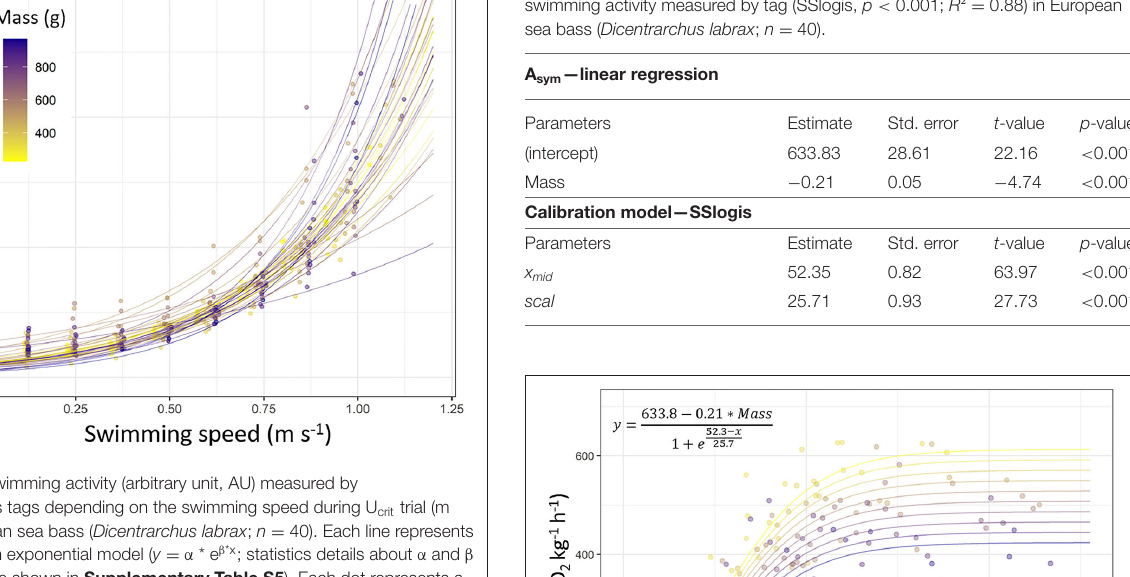
TABLE 2 | Outputs of the significant linear regression for the A sym parameter ( p < 0.001; R ² = 0.36), and for the model mapping the MO 2 depending on